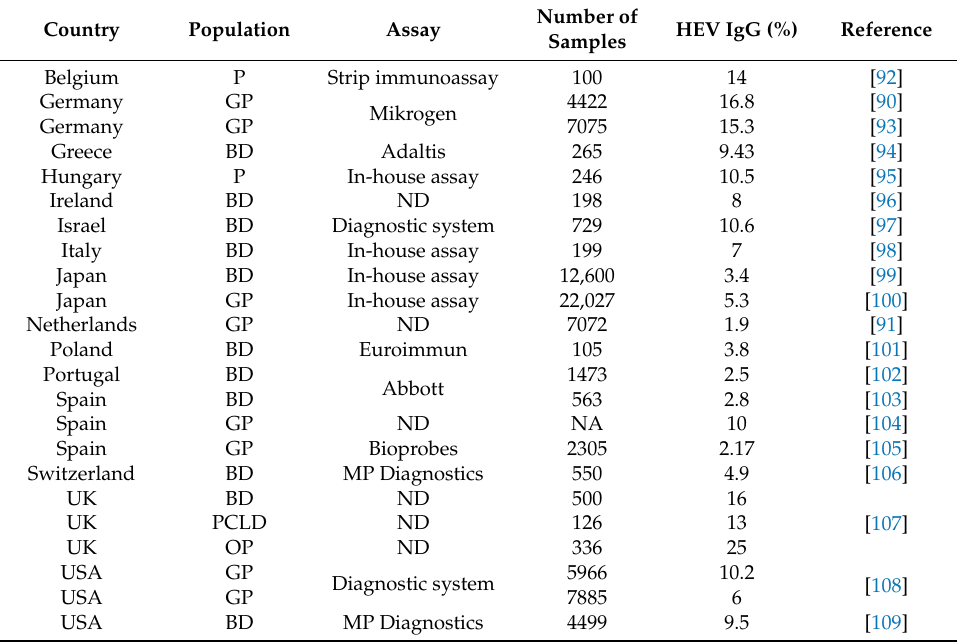
Table 5. Prevalences of HEV IgG observed in industrialized countries with assays other that Wantai HEV-IgG